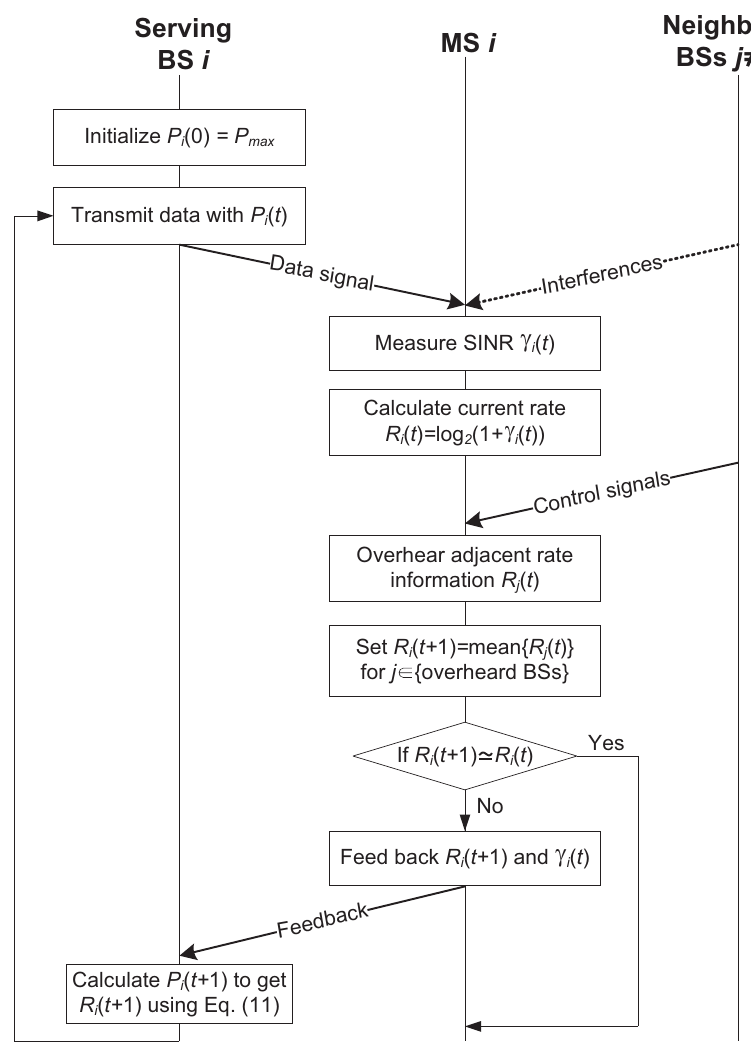
Figure 2. Flow chart of the proposed transmit power control (TPC)